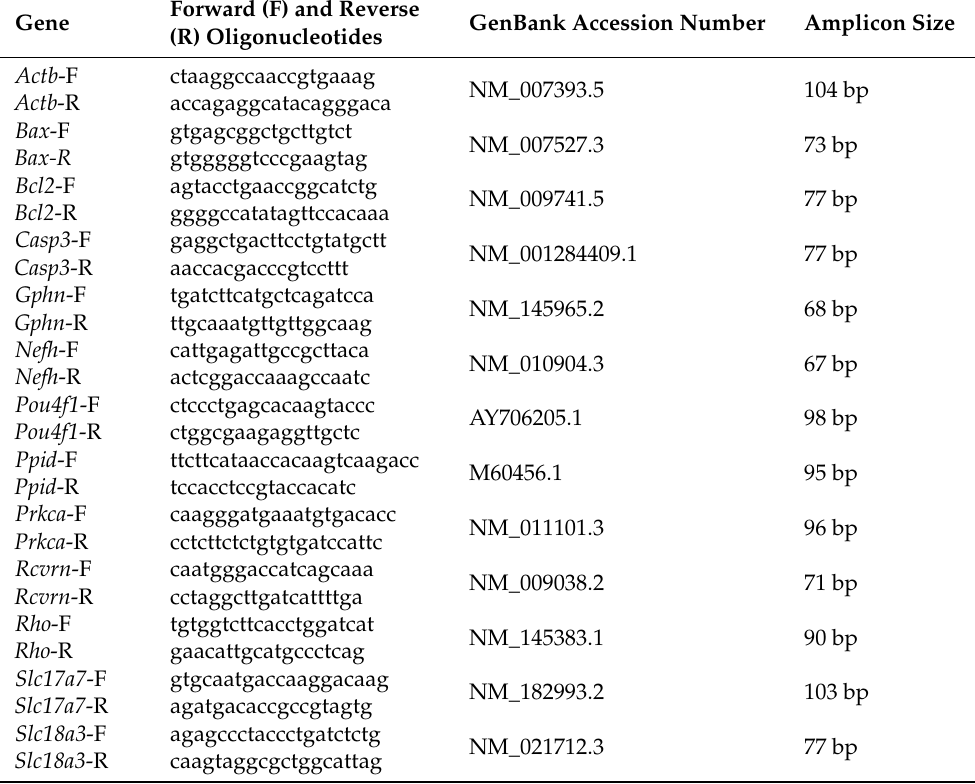
Table 3. Sequences of oligonucleotides. The listed oligonucleotide pairs were used in quantitative real-time PCR experiments, while Beta-actin (Actb) and Cyclophilin (Ppid) served as housekeeping genes. The predicted amplicon sizes are given. Abbreviations: F = forward, R = reverse, acc. no. = accession number, bp = base